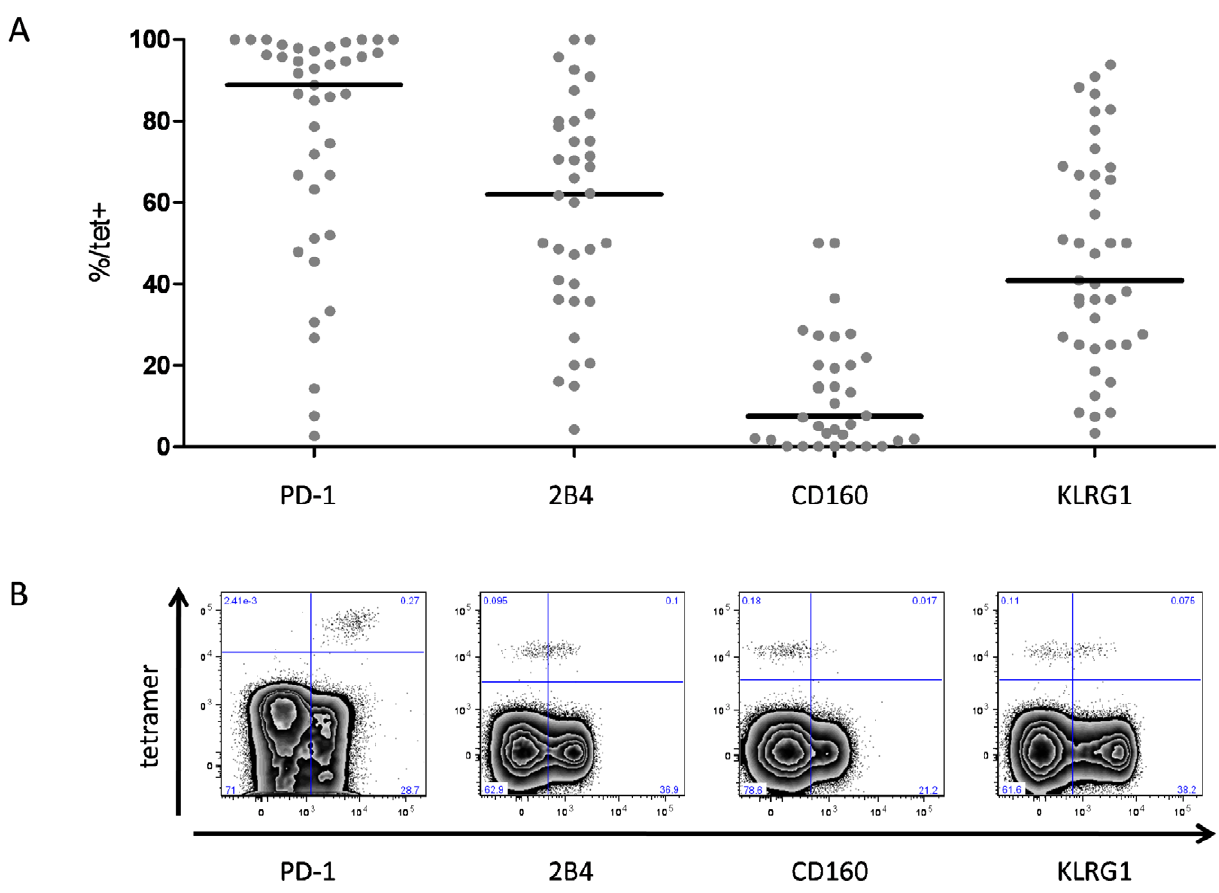
Figure 2. Expression of PD-1, 2B4, CD160 and KLRG1 on HCV-specific CD8 + T cells. (A) Frequency of inhibitory receptor expression on HCV-specific CD8 + T cells. Each dot represents inhibitory receptor expression on epitope-specific CD8 + T cells. Median expression of inhibitory receptors in the study cohort was 88,9% (PD-1), 62,0% (2B4), 7,4% (CD160), and 40,8% (KLRG1). (B) Representative tetramer stainings chosen to depict approximately the median inhibitory receptor expression of the total cohort. Plots are displayed using biexponential transformation (FlowJo